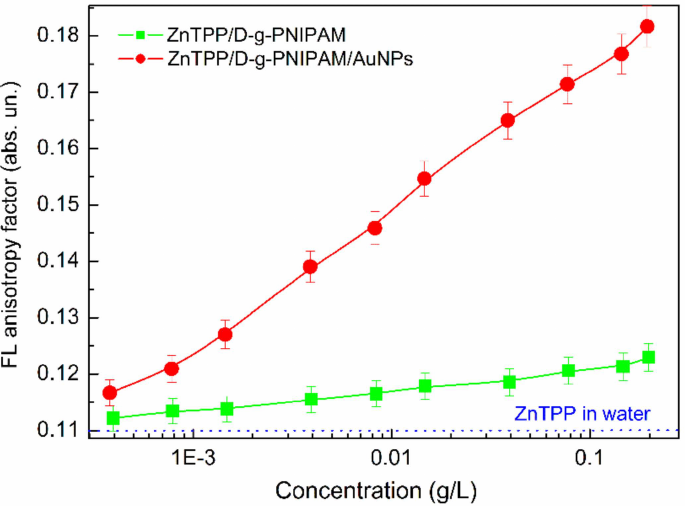
Figure 6. Concentration dependence of FL anisotropy for ZnTPP in aqueous solutions of ZnTPP/D- g-PNIPAM (squares) and ZnTPP/D-g-PNIPAM/AuNPs (circles). Squares and circles show the dependence on D-g-PNIPAM and AuNPs concentration respectively. Concentration of ZnTPP is 0.001 g/L. The blue dotted line corresponds to ZnTPP in